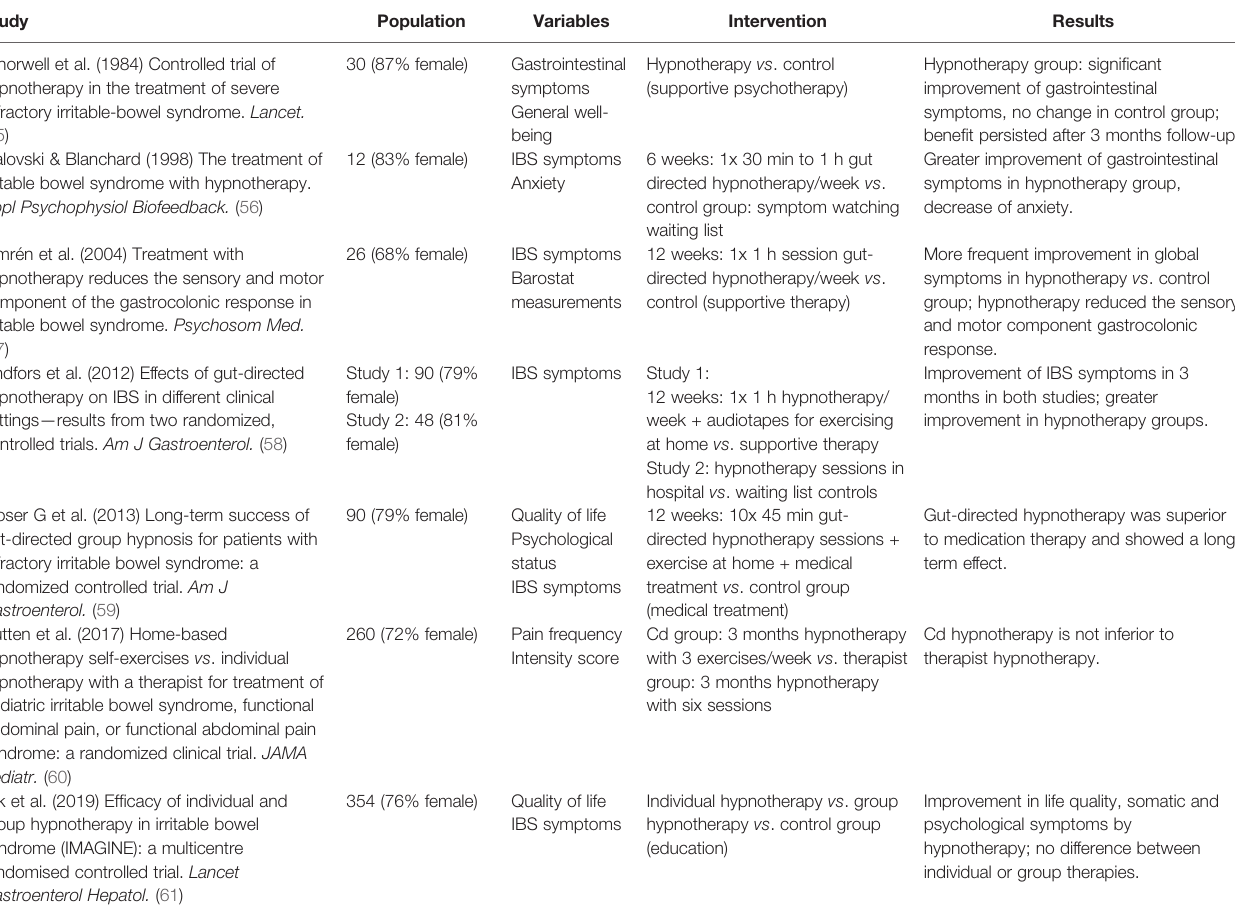
TABLE 5 | Randomized controlled studies investigating the effects of hypnotherapy in patients with irritable bowel